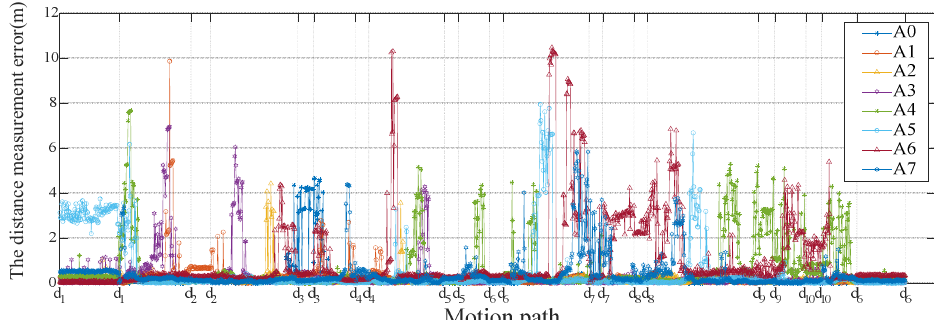
Figure 12. Range error of each anchor in Experiment 1.